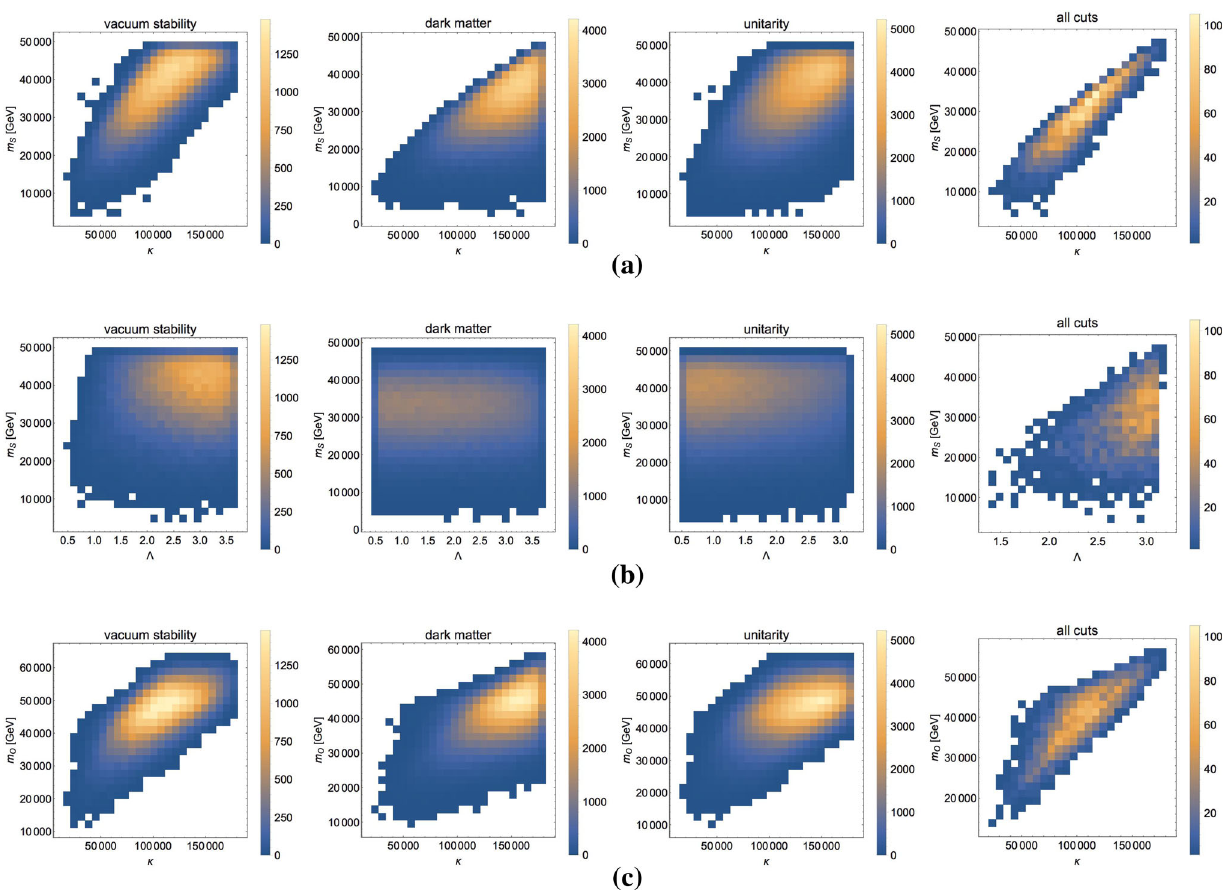
Fig. 3 Left column: selected two-dimensional planes of the parameter space after cutting for vacuum stability. Second column: same, but cut for dark matter. Third column: same, but cut for unitarity. Right col- umn: same, but after all three cuts. Top: distribution of κ against m S . Middle: distribution of (cid:8) against m S . There is a clear cutoff at (cid:8) (cid:20) π